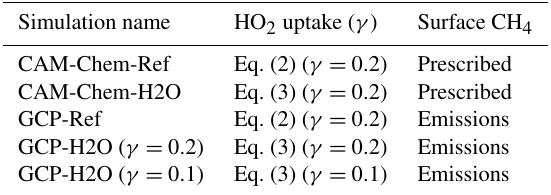
Table B2. Description of the sensitivity test performed with CAM- Chem before any assimilation